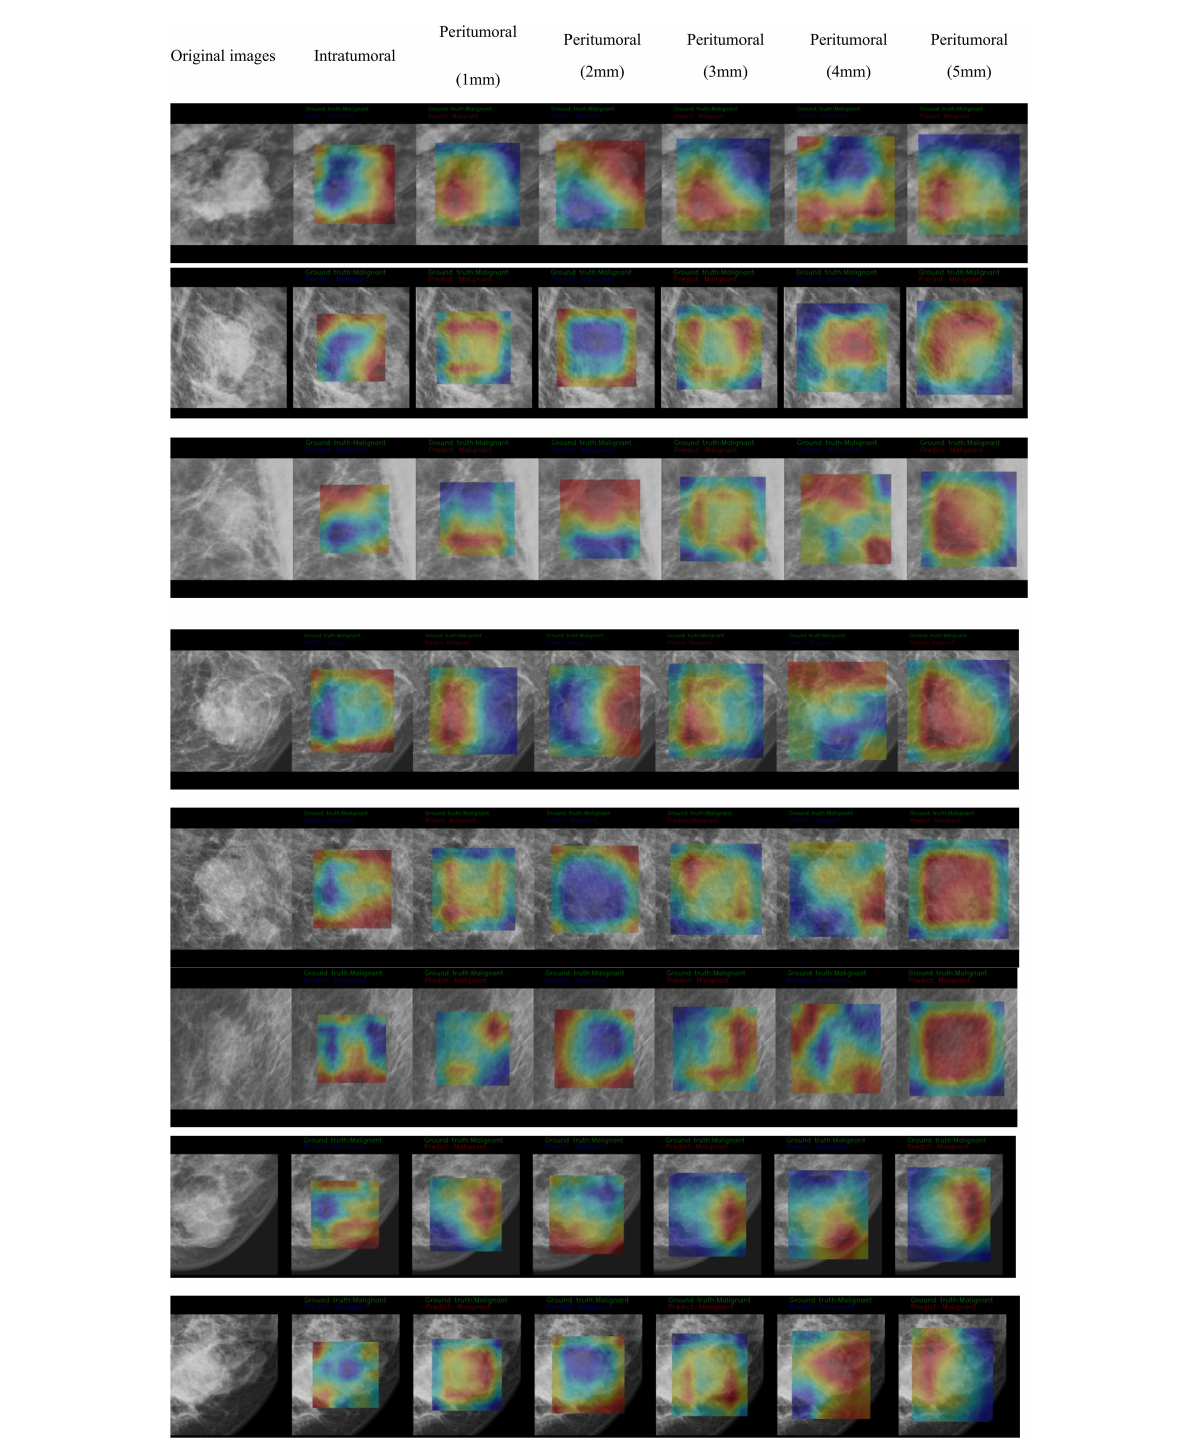
FIGURE 4-1 CAM status of tumoral and peritumoral regions were observed on 8 patients with malignant masses. All the regions were correctly